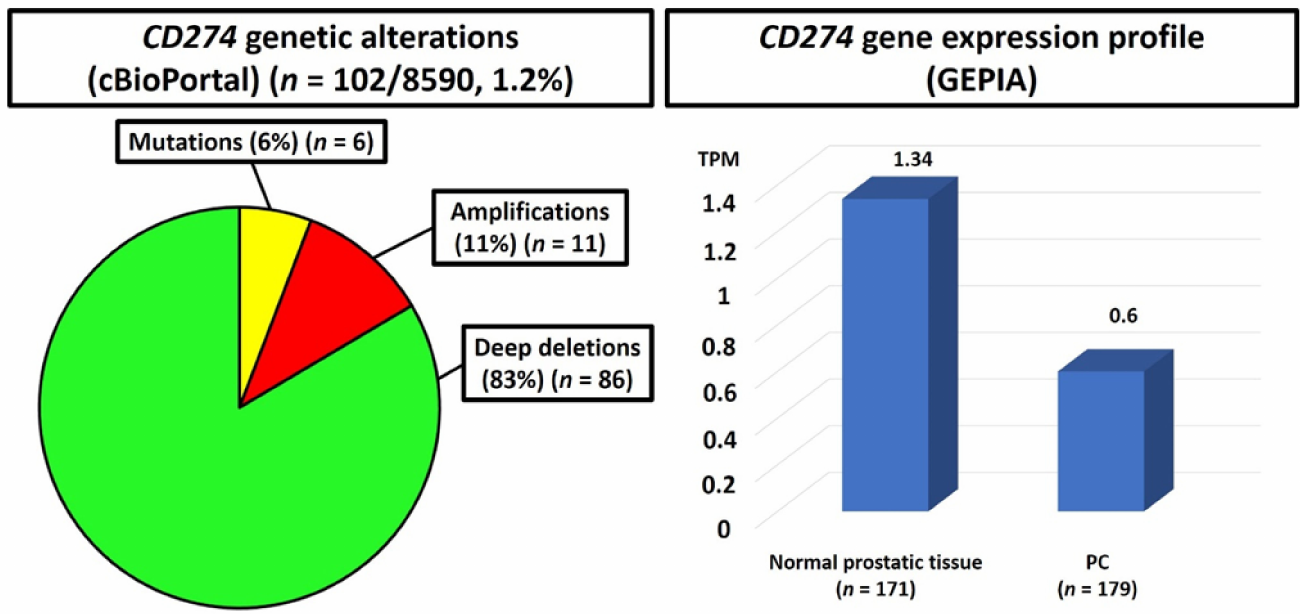
Figure 3. Results of big data analysis: CD274 genetic alterations (( left ): cBioPortal; https://www.cbioportal.org/ (accessed on 12 August 2021)) and gene expression profile (( right ): GEPIA database; http://gepia.cancer-pku.cn/index.html (accessed on 12 August 2021)). PC: prostate cancer; TPM: transcripts per millionset. On the right, the median TPM values of CD274 gene expression in normal prostatic tissue and PC are repoted above the respective